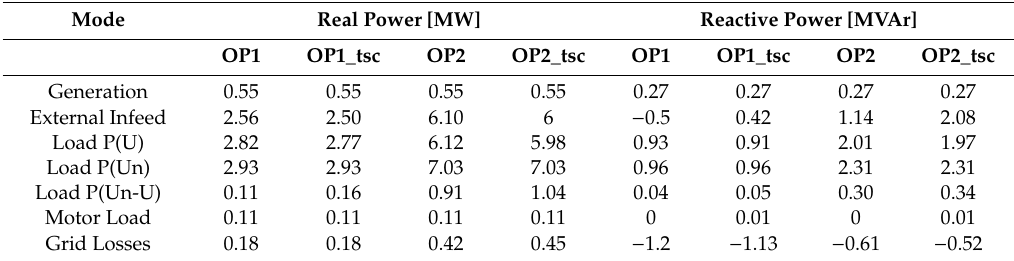
Table 3. Results of load flow